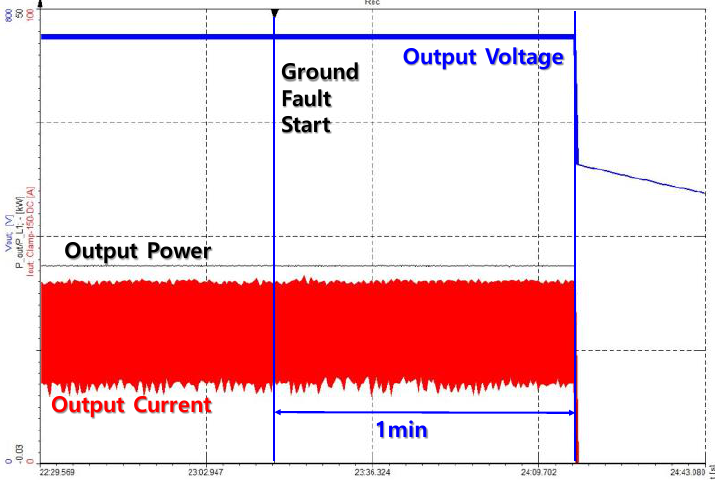
Figure 7. Earth ground fault test results of the AC/DC power converter.